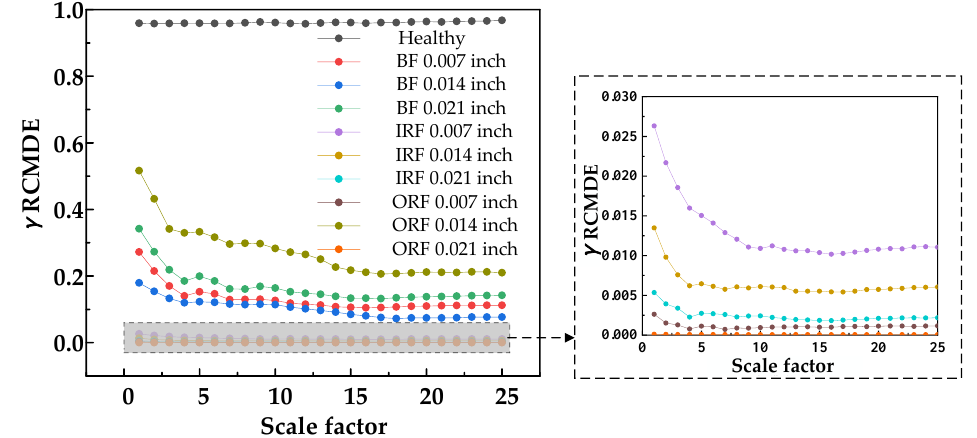
Figure 14. γ RCMFE entropy values of 25 scale factors under different damage degrees.